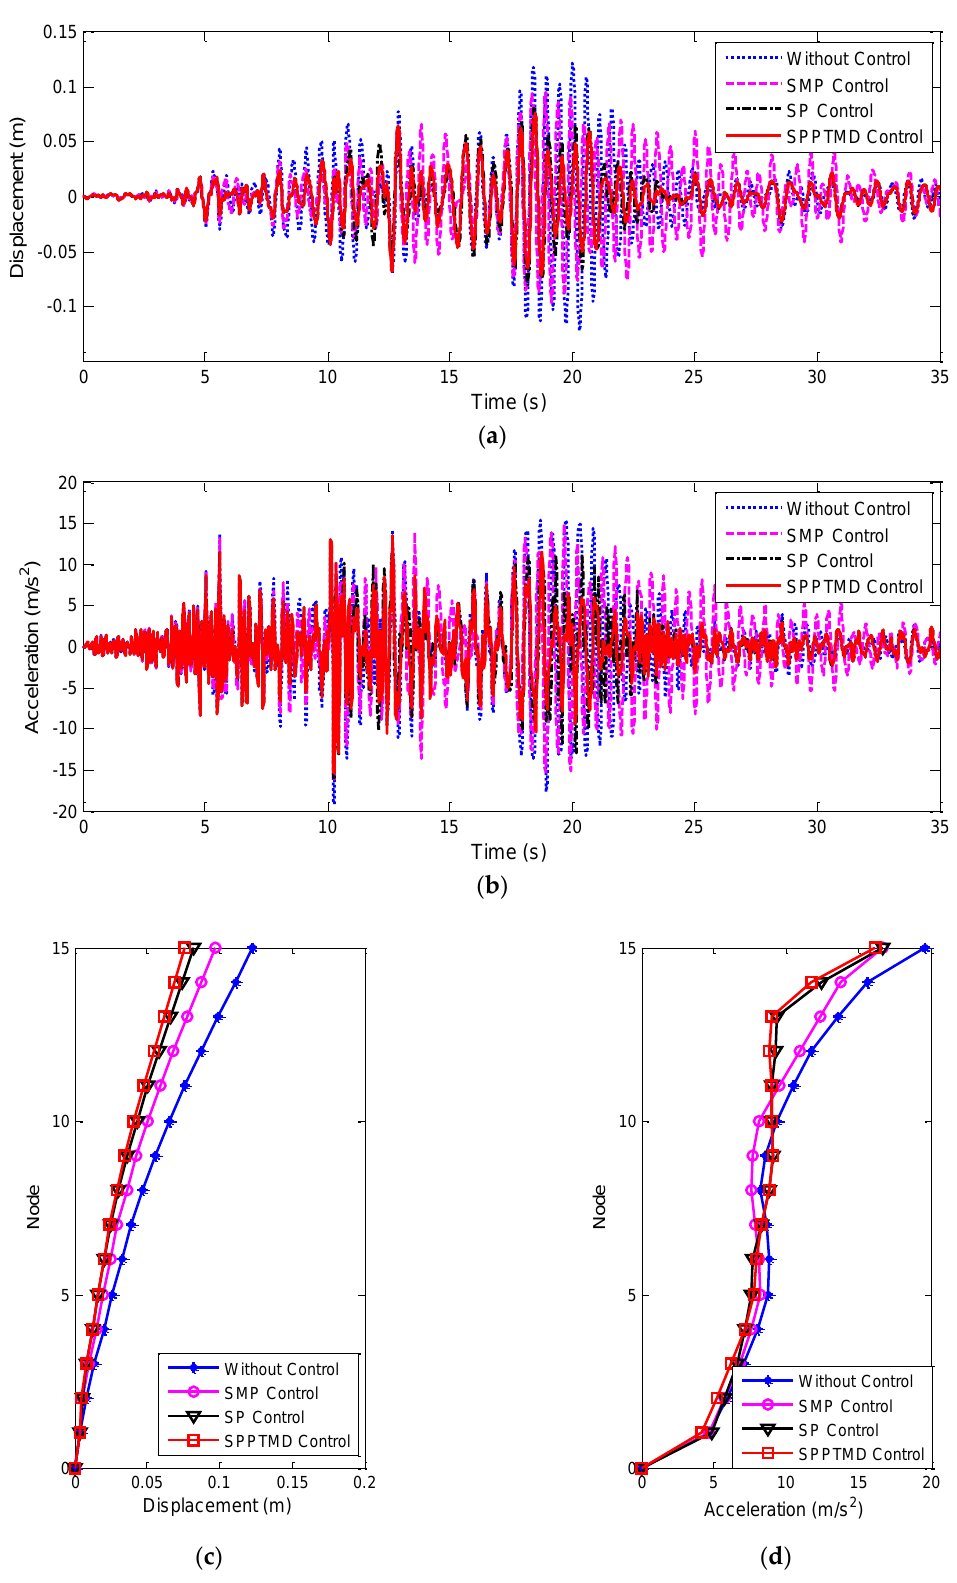
Figure 11. Seismic response of the tower top under EQ2: ( a ) displacement; ( b ) acceleration; ( c ) envelope of displacement; and ( d ) envelope of acceleration.